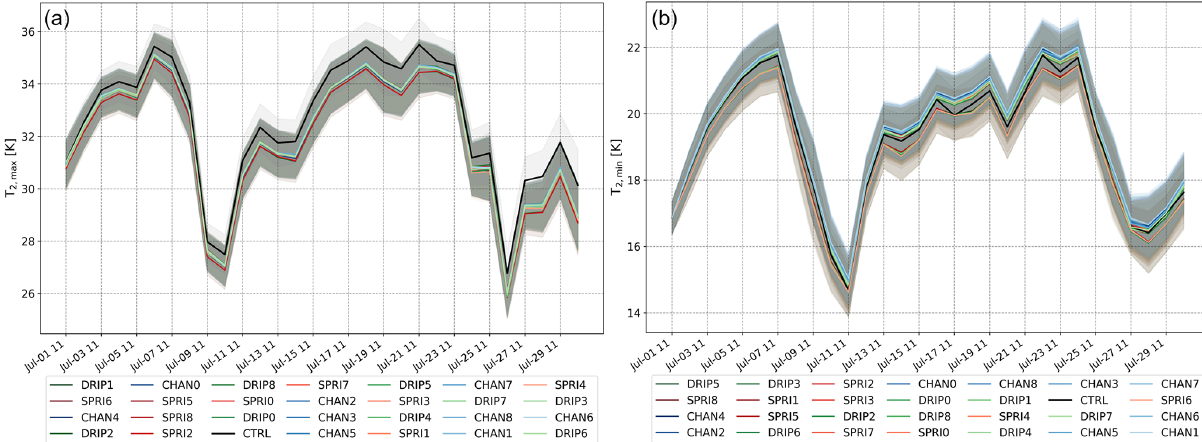
Figure 12. Time series of the daily maximum (a) and minimum (b) T 2 averaged over the irrigated area for all sensitivity tests and the control. Black color shows the CTRL run, blue the CHAN (option 1), green the DRlP (option 2), and red the SPRI (option